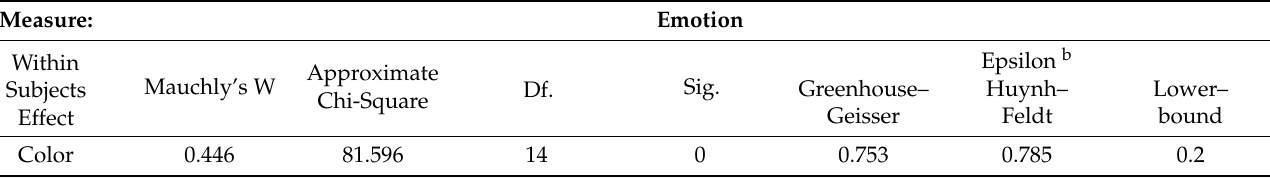
Table 6. Multivariate test a .